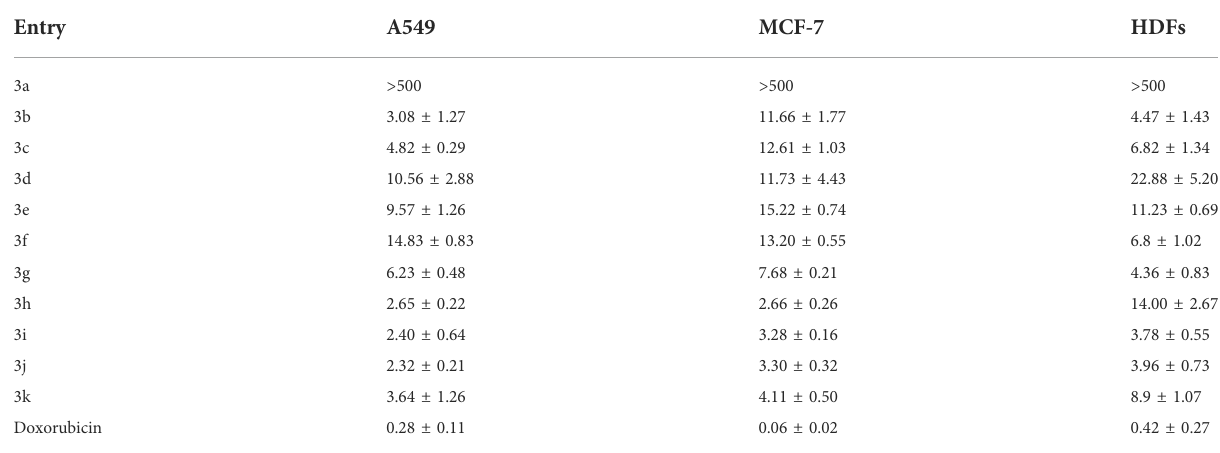
TABLE 1 IC 50 values of the tested compounds 3a-k after the MTT assay showing variable responses of the treated cell lines.